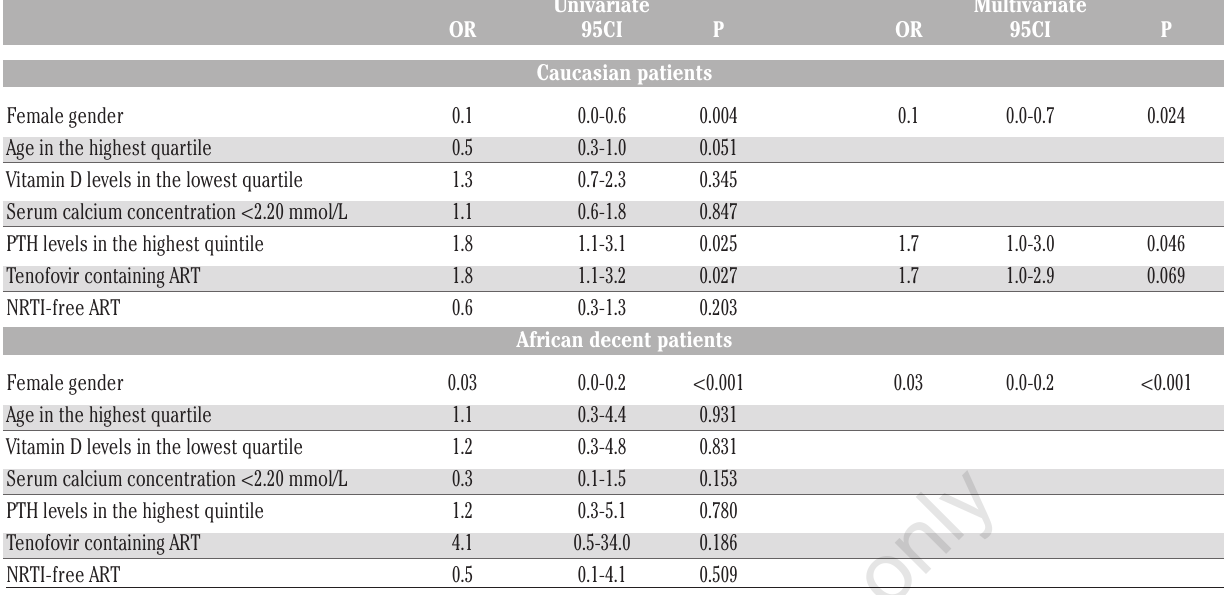
Table 3. Association of different binary factors on the occurrence of elevated sion analysis analyzed per ethnicity.